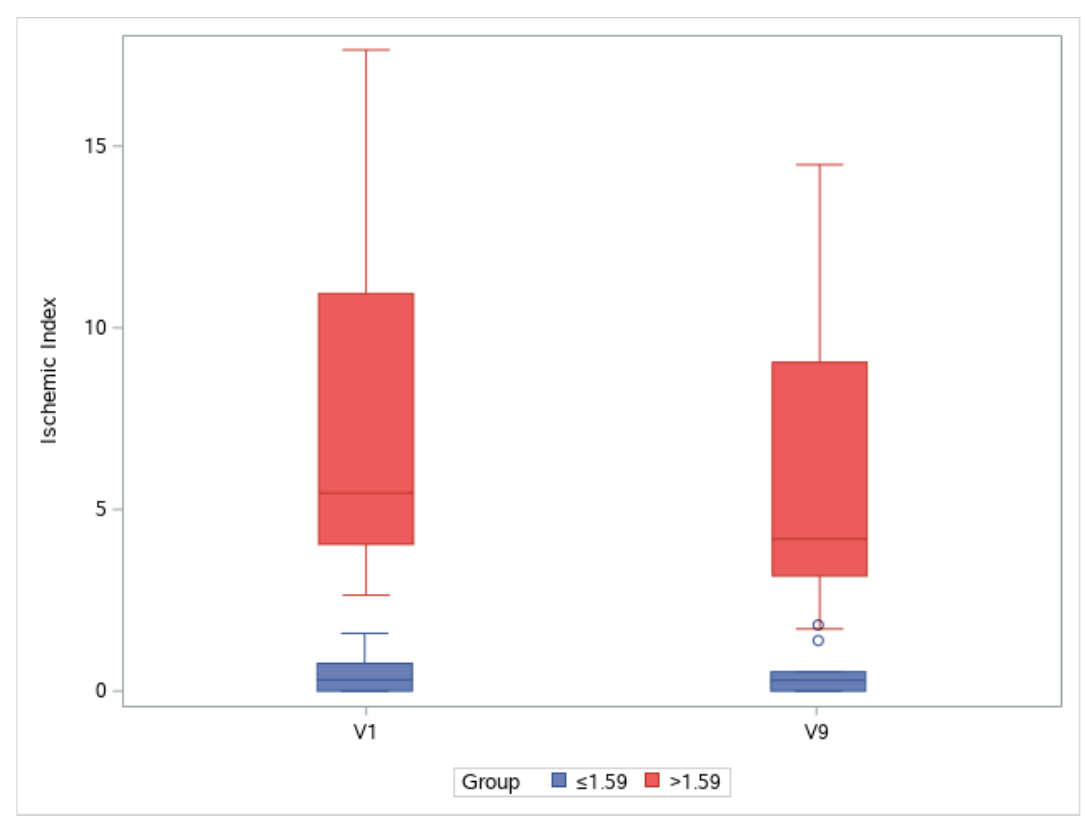
Figure 6. Changes in ischemic index between V1 and V9. Groups are separated by a cutoff value of 1.59% at baseline (V1): V, visit.